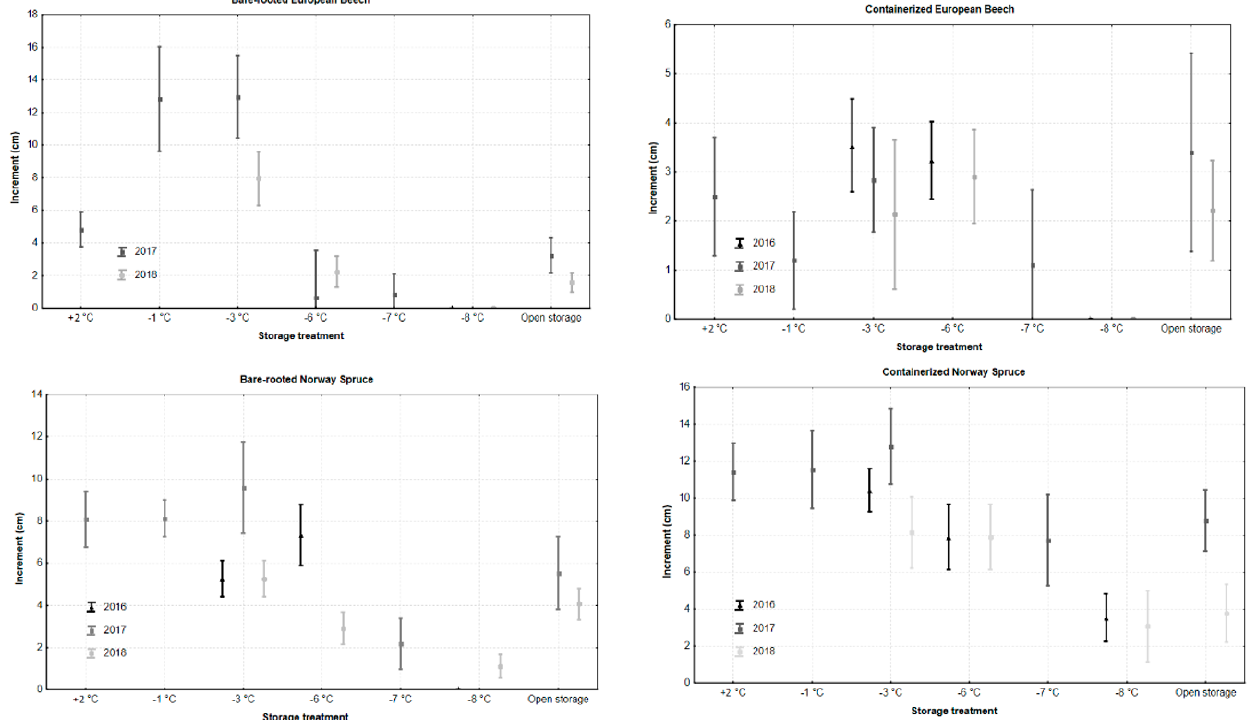
Figure 6. Height increment of the bare-rooted and containerized European beech and Norway spruce plants in various storage treatments at the end of the first growing season in three years of the research.